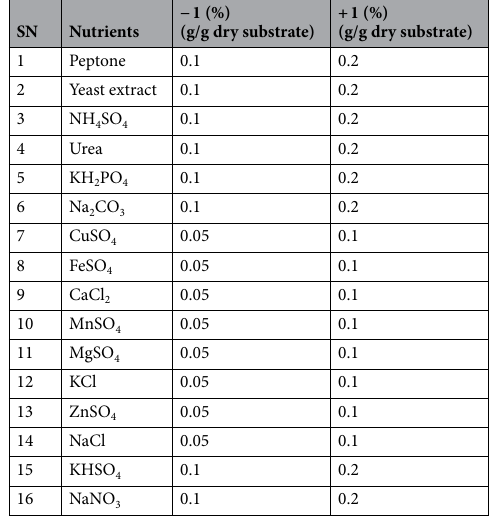
Table 1. Concentration of the sixteen independent nutrient variables screened by